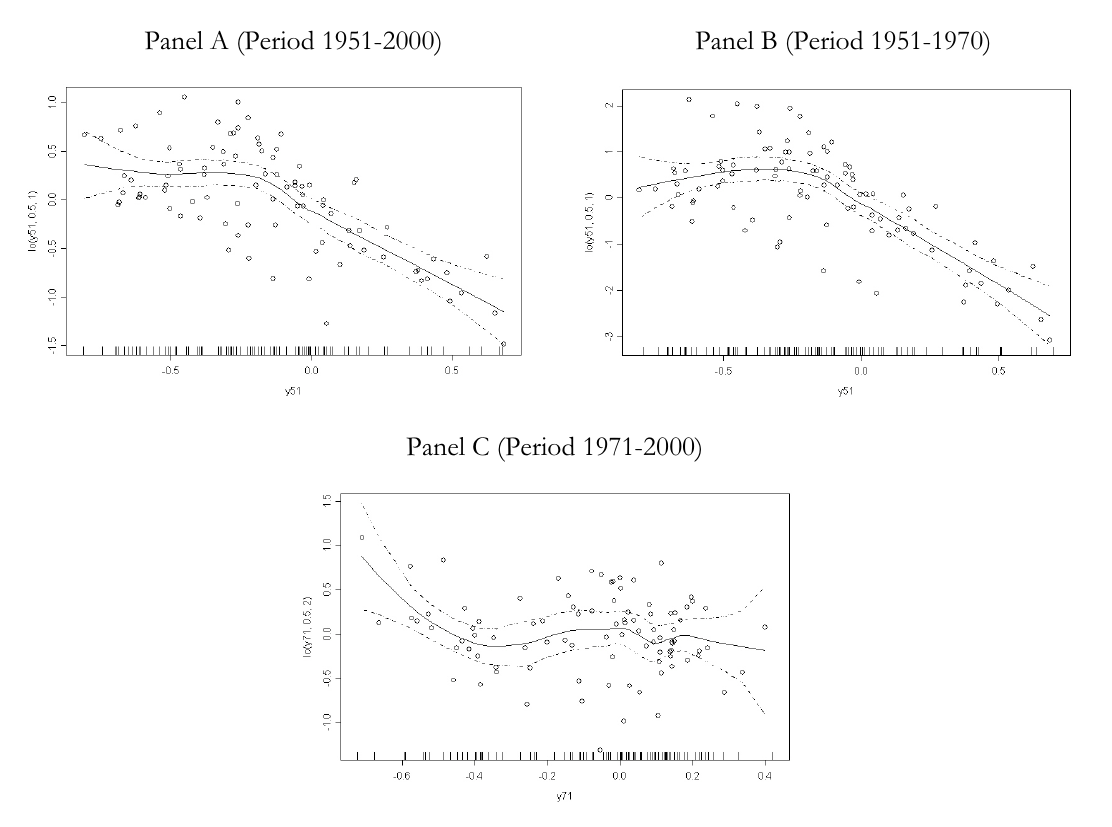
Figura 3 – Per capita GDP Levels vs Growth Rates (Nonparametric Regression).